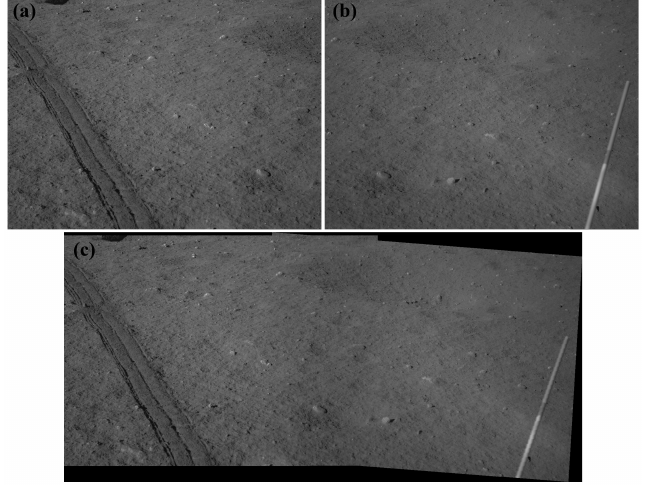
Figure 6. Original images and mosaic image. ( a ) left original image; ( b ) right original image; ( c ) mosaic